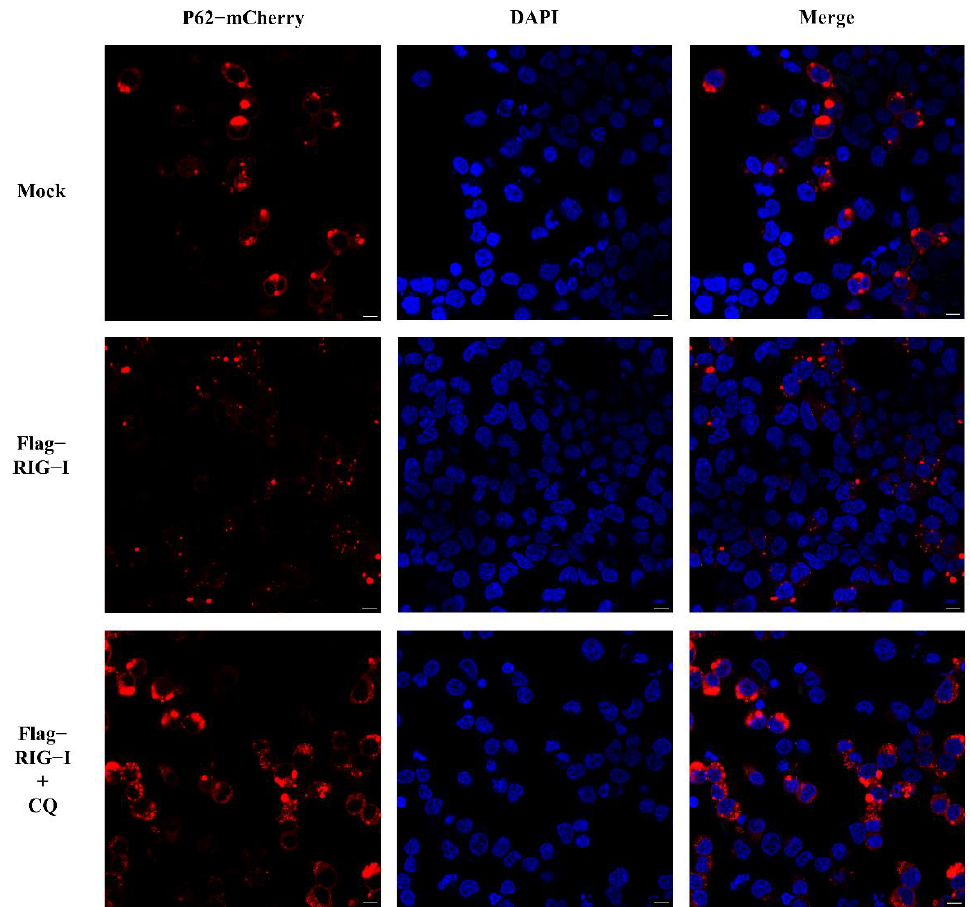
Figure 4. Observation of P62 with overexpression of RIG-I in HEK 293T cells with and without chloroquine treatment. Scale bar: 10 μm.